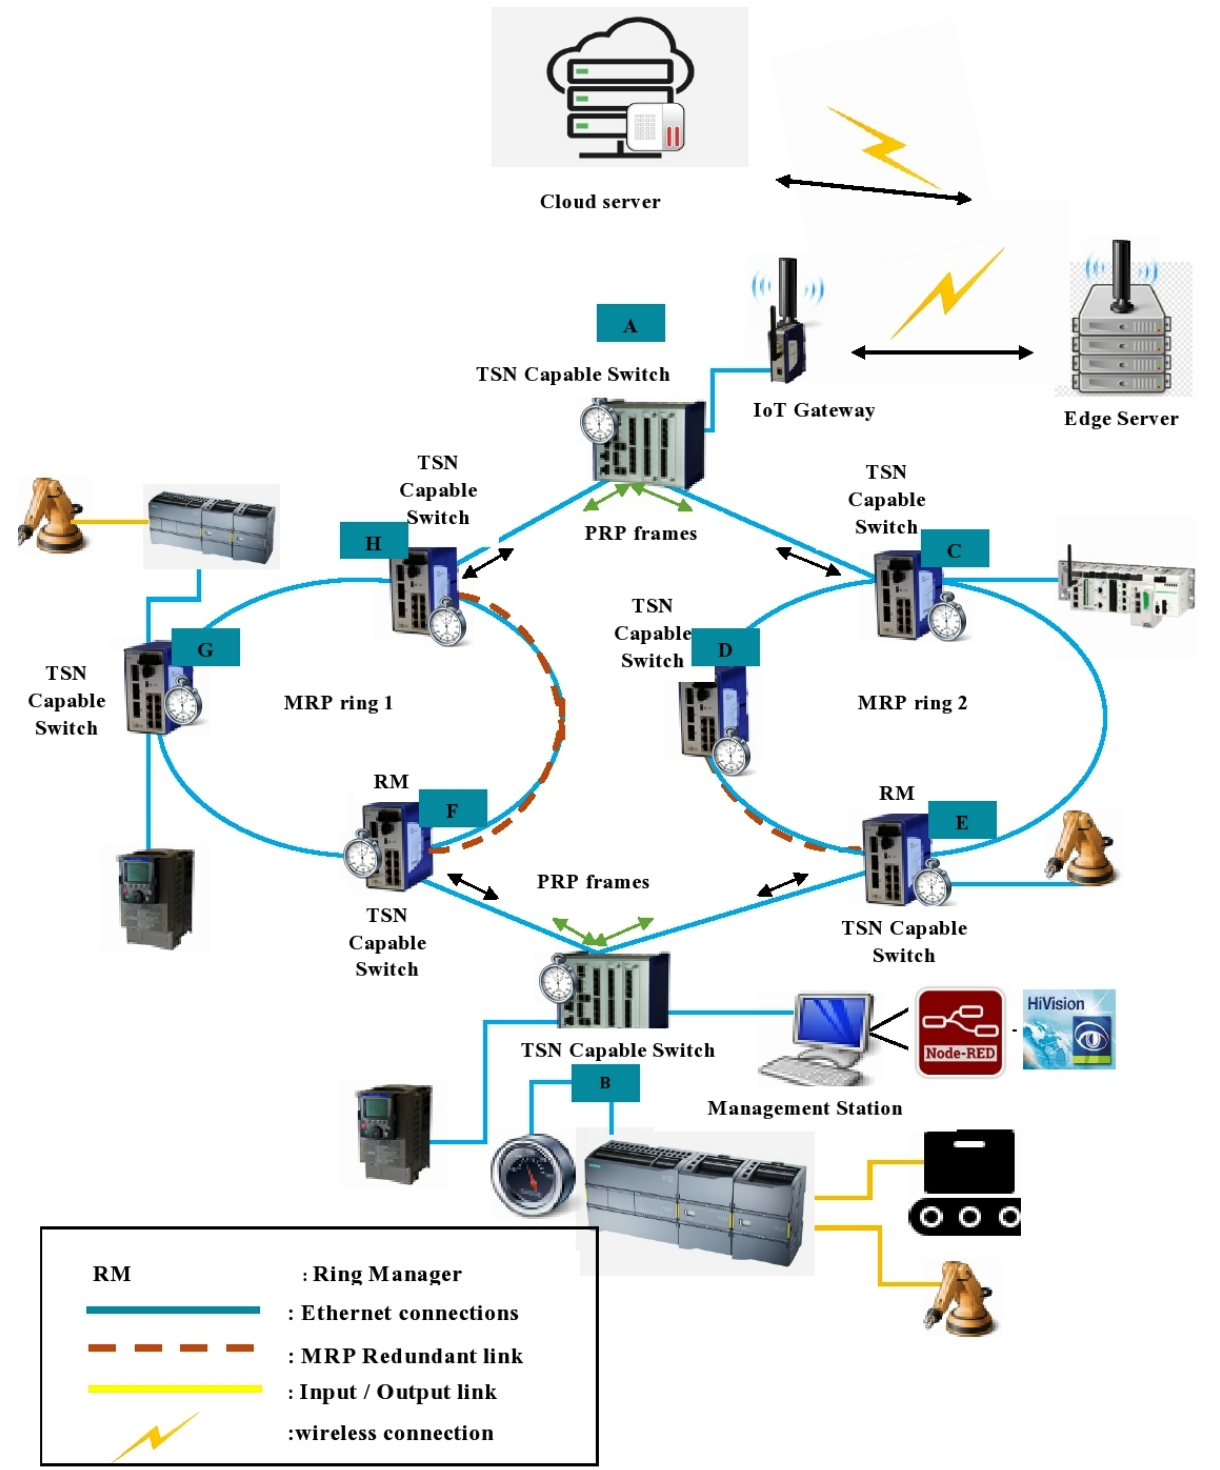
Figure 14. Network communication prototype using